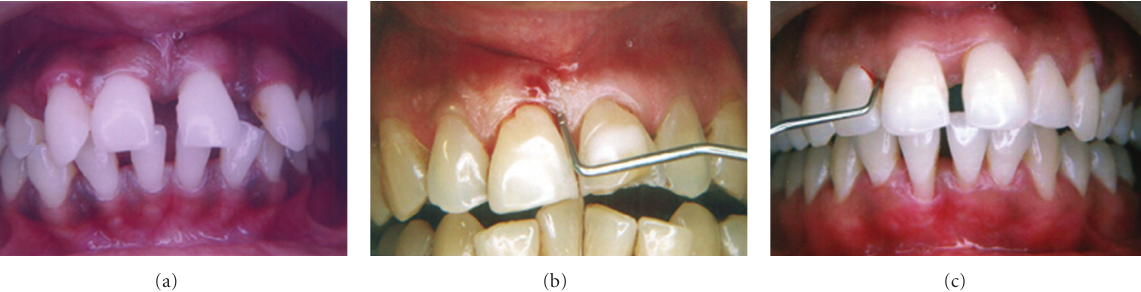
Figure 1: (a) Patient presenting with flaring of the anterior teeth. (b) and (c) Deep pockets revealed by probing in a periodontium with lack of clinical inflammation.